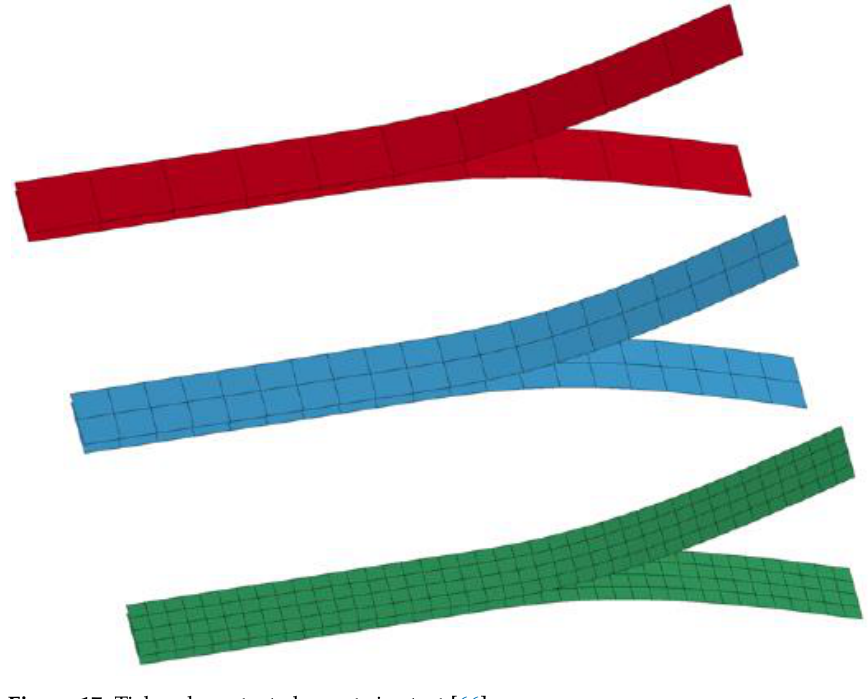
Figure 17. Tiebreak contact element size test [66].